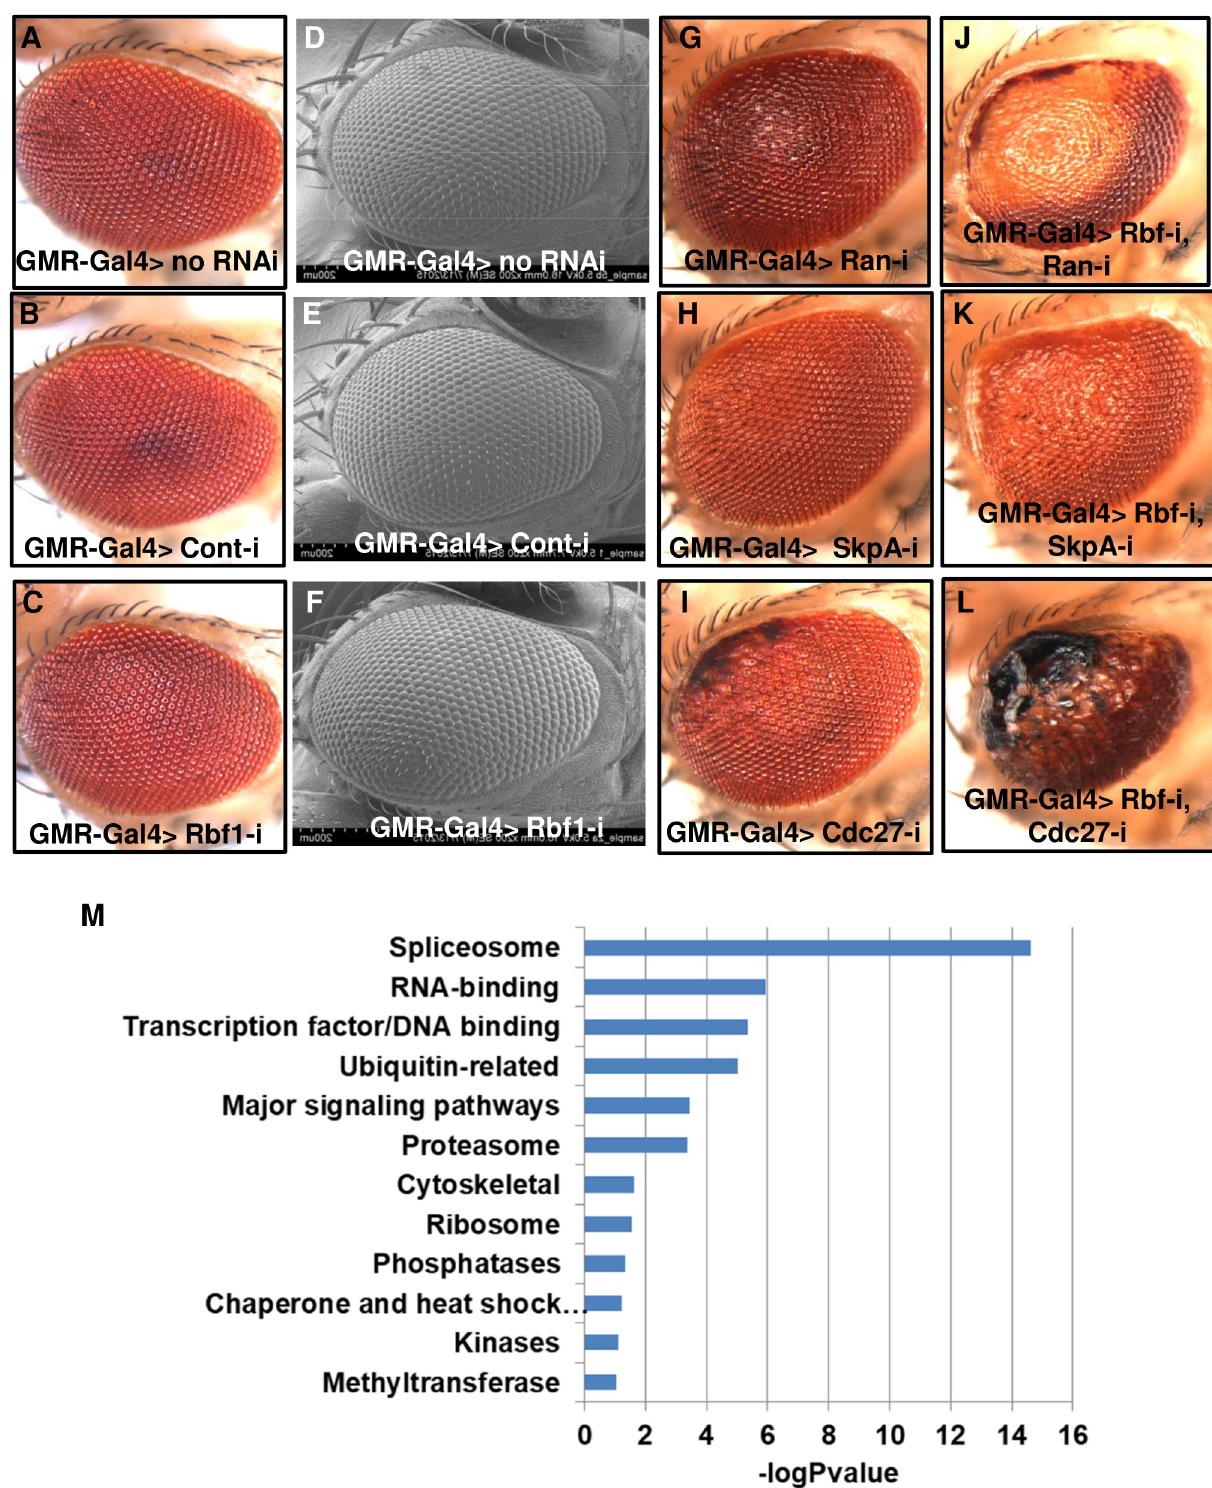
Fig 1. Drosophila synthetic lethality eye screen in Rb1 -deficient background. Drosophila eye pictures of the following genotypes: GMR-Gal4 > no RNAi (A) GMR-Gal4 > Cont-i (B) GMR-Gal4 > Rbf1-i (C) . Scanning electron microscope images of a Drosophila eye of the following phenotypes: GMR-Gal4 > no RNAi (D) GMR-Gal4 > Cont-i (E) GMR-Gal4 > Rbf1-i (F) . Drosophila eye picture of the following phenotypes: GMR-Gal4 > Ran RNAi (G) , GMR-Gal4 > SkpA RNAi (H) , GMR-Gal4 > Cdc27 RNAi (I) , GMR-Gal4 > Rbf1-i , Ran RNAi (J) , GMR-Gal4 > Rbf1 -i, SkpA RNAi (K) , GMR-Gal4 > Rbf1 -i, Cdc27 RNAi (L) . GO enrichment analysis of Drosophila eye hits (M) .